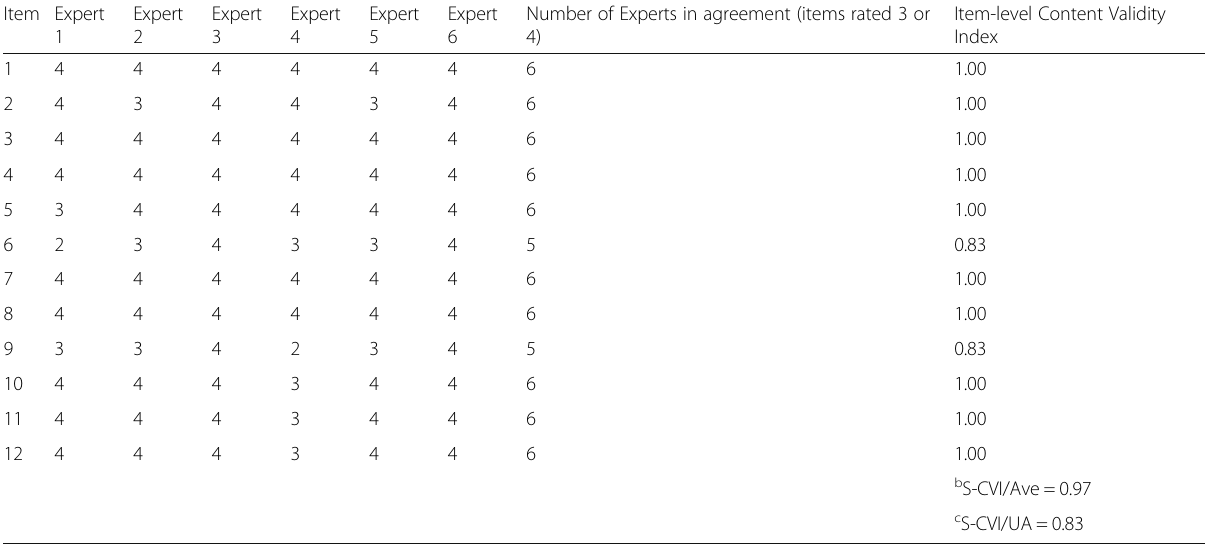
Table 4 Content validity: ratings of iHOT12-Gr items by six experts on a 4-point scale a Item Expert 1